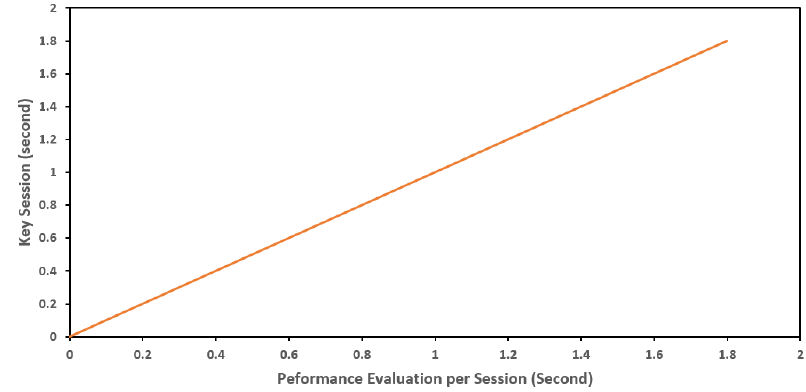
Figure 11. Performance Evaluation.